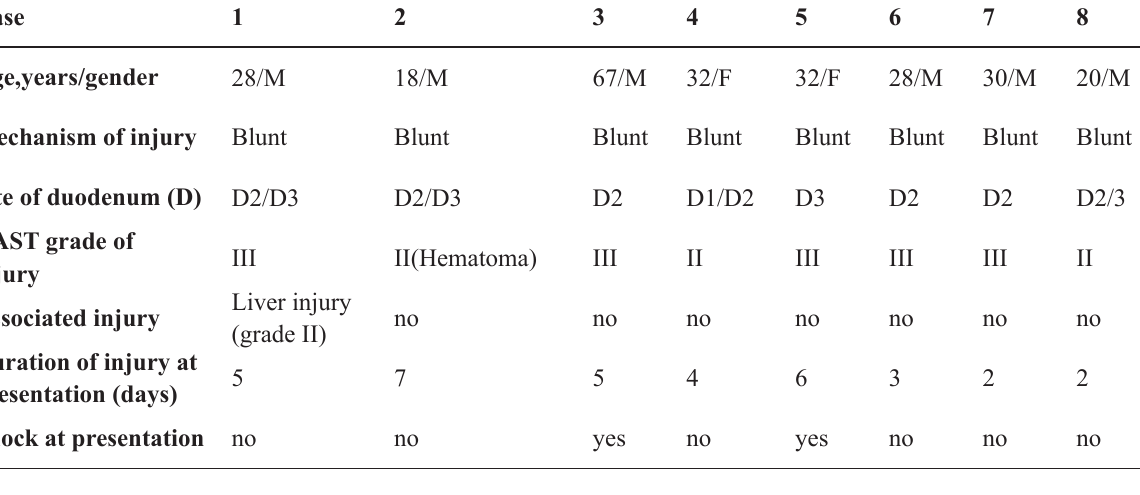
Table 1: Demography and clinical profile of the patients with duodenal injury Case